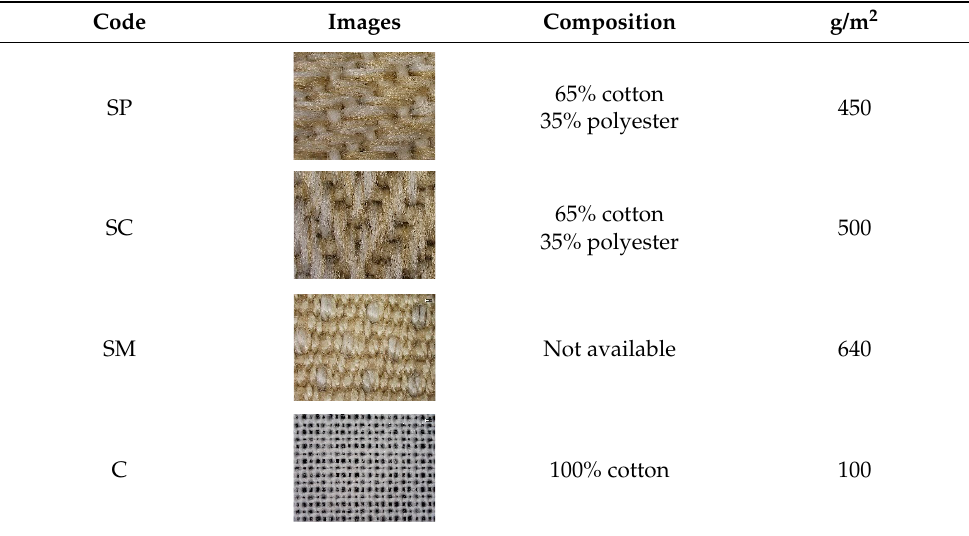
Table 3. Fabrics used as supports for nano-TiO 2 -based coatings.